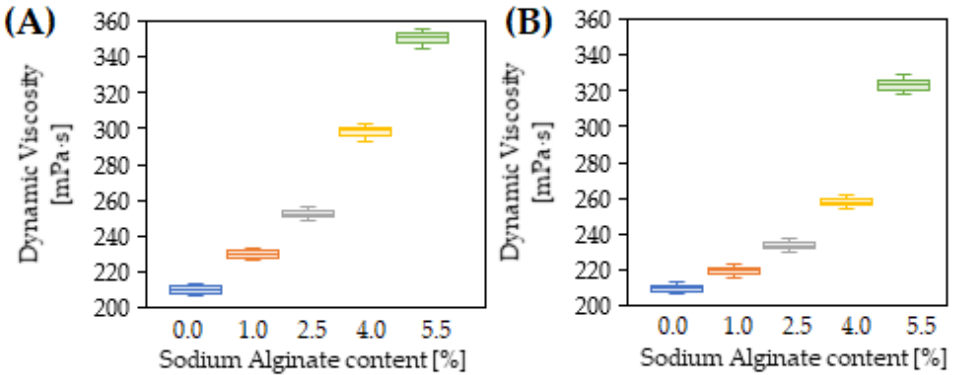
Figure 4. Dynamic viscosity test results of 35/50 bitumen modified with sodium alginate ( A ) and 35/50 bitumen modified with sodium alginate in presence of crosslinking agent ( B ).